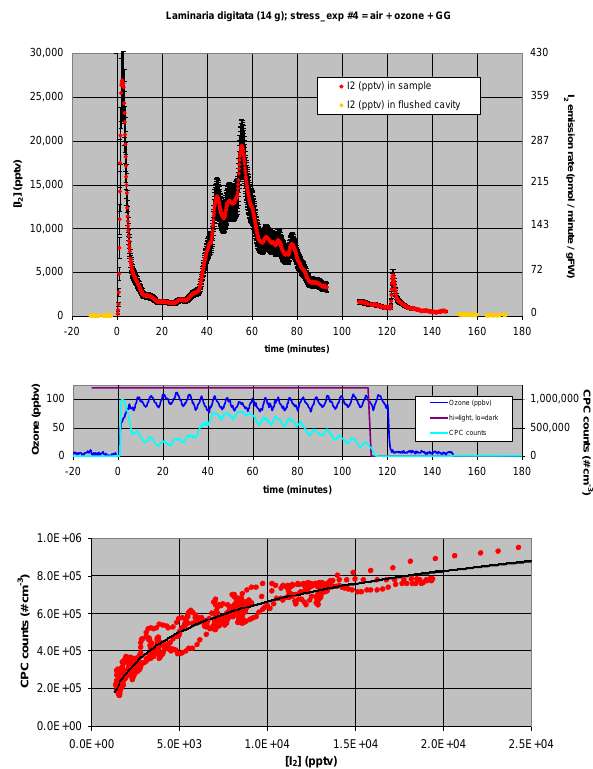
Fig. 7. Time series of I 2 mixing ratios and emission rates for the L. digitata air + ozone + GG multiple stress experiment #4 (upper panel). The middle panel shows time series of the ozone concentration (dark blue), the particle number concentration (light blue) and whether the seaweed vessel was exposed to the room lights (purple). The bottom panel shows a correlation plot of particle counts versus I 2 mixing ratio for data between t =3 and 110min (i.e. excluding the upward part of the first strong emission event and all data after the seaweed vessel was covered). The heavy black line is a fit of the type: CPC counts =A × log[I 2 ]+B.